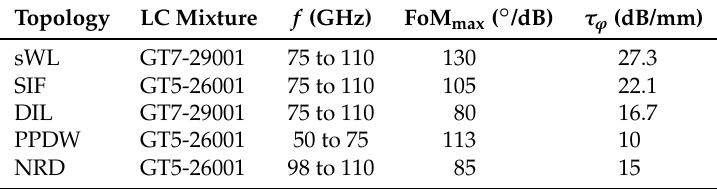
Table 2. Summary of the tunable LC phase shifter results based on dielectric waveguide topologies.